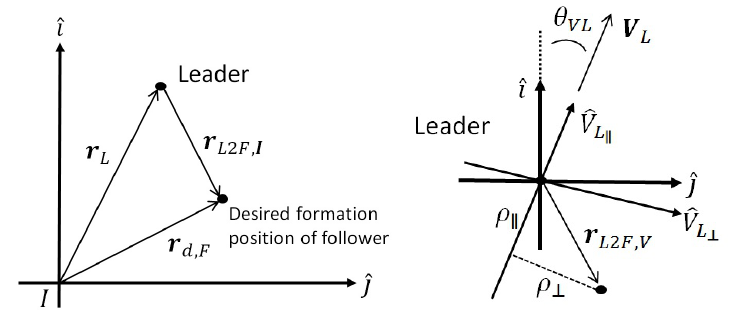
Figure 4. Relative position of the leader and the follower (left); tangential coordinate and leader’s velocity V L in a horizontal plane